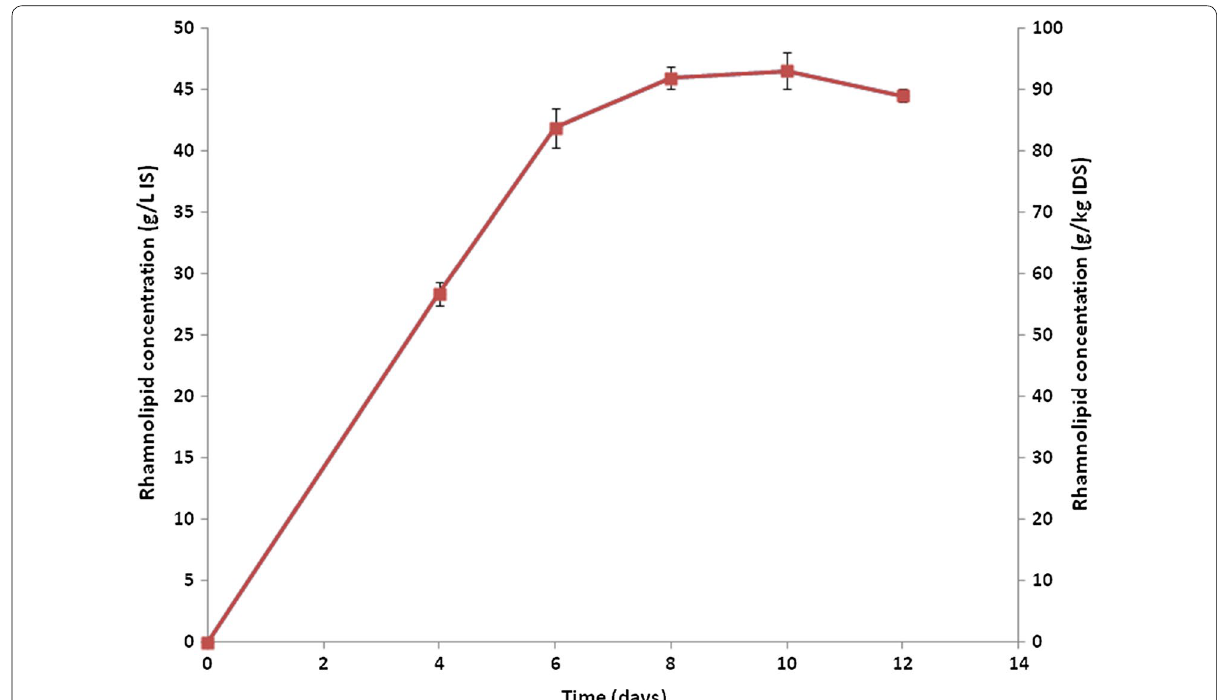
Fig. 6 Time course of the RL production by P. aeruginosa 15GR in SSF using optimized conditions. Values plotted are the means of triplicate results while error bars indicate the standard deviation of the